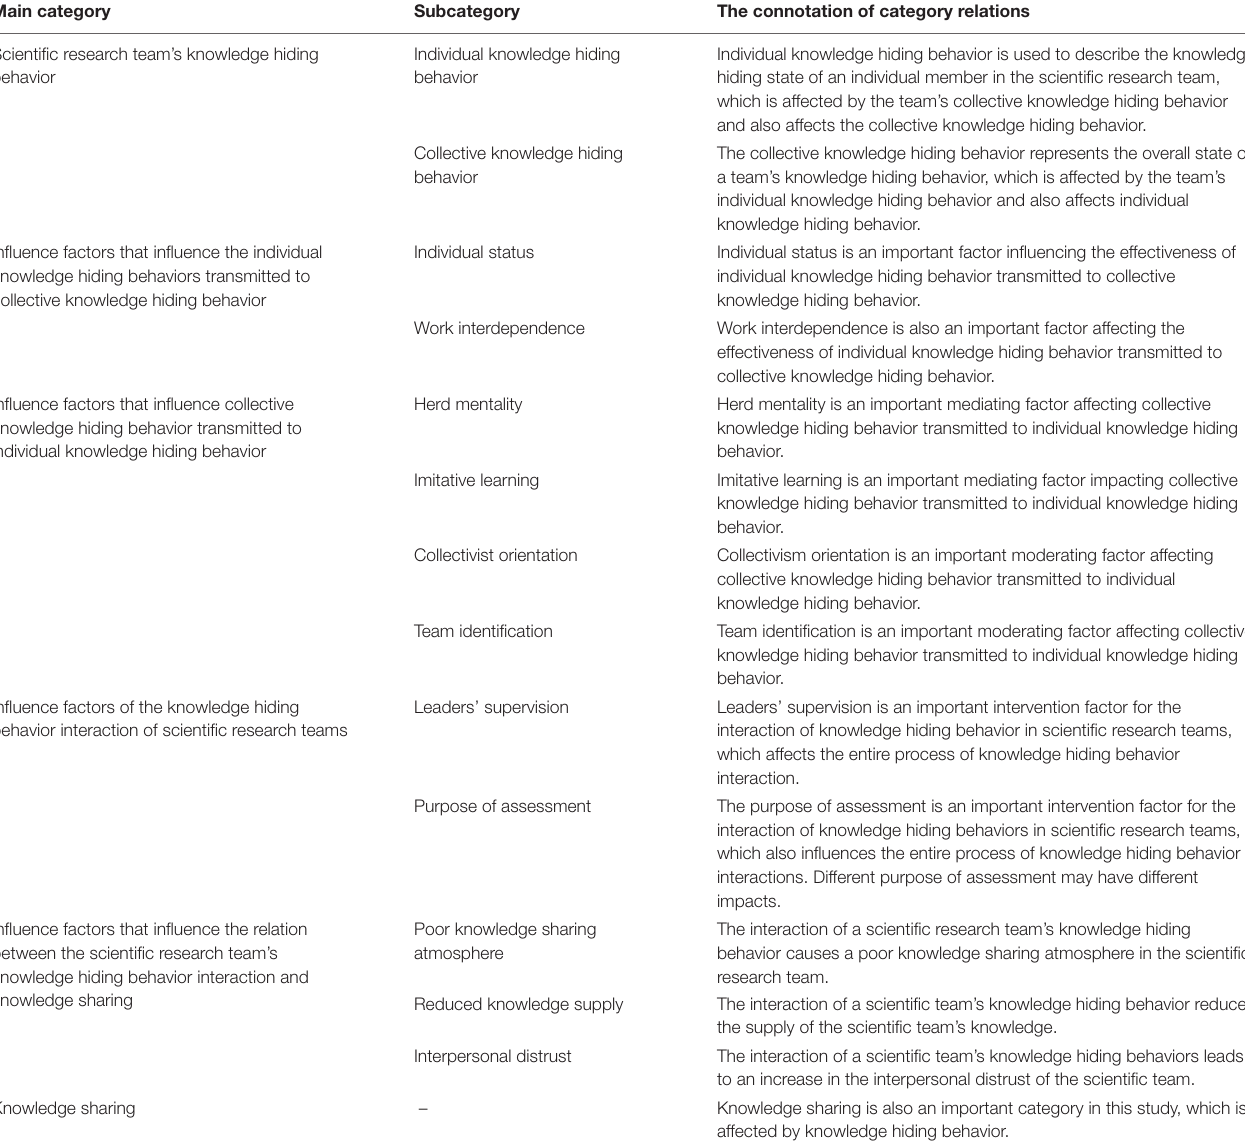
TABLE 3 | Results of axial